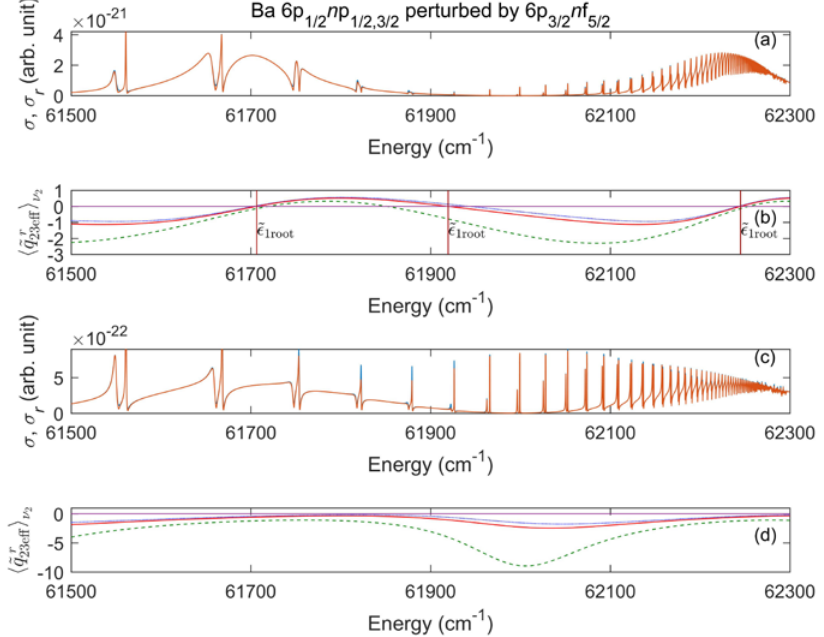
(cid:10) (cid:11) r r q  (cid:101) q 23eff ν 2 23eff ν 2